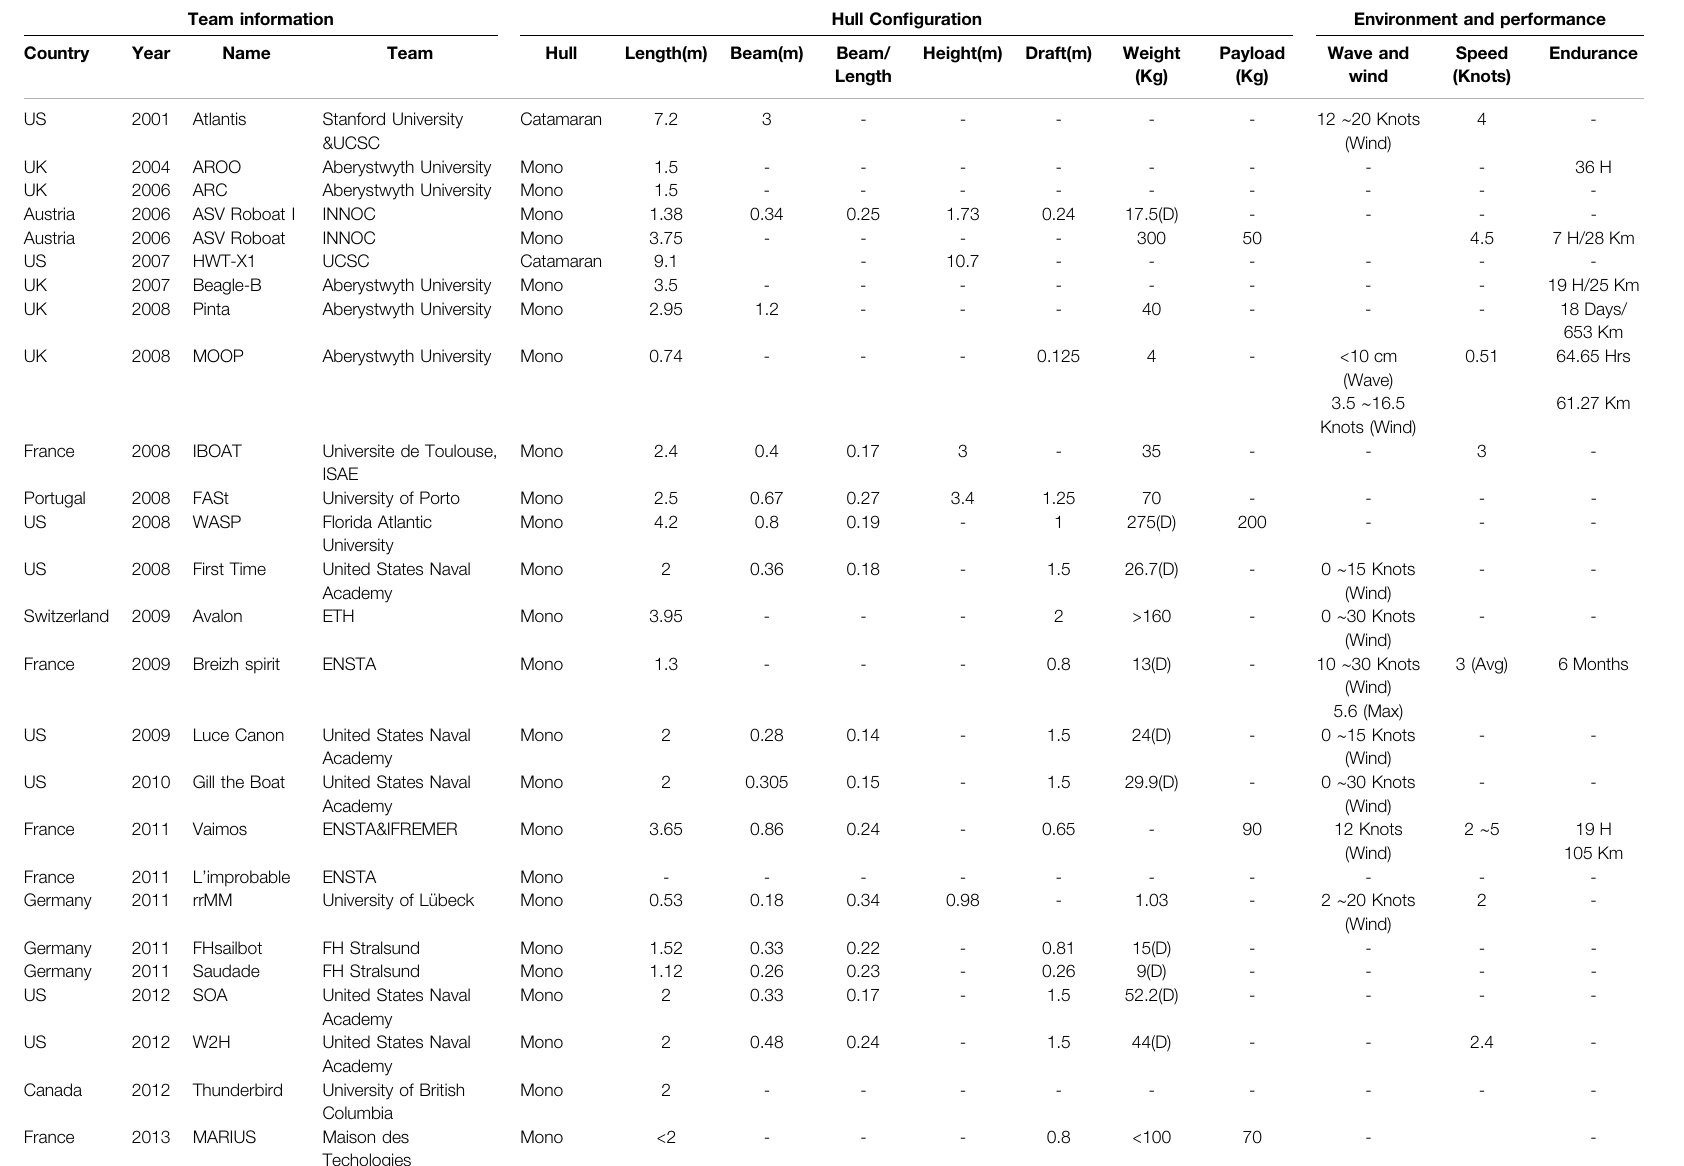
TABLE 1 | The sailboats con fi guration about team information, hull con fi guration and environment in different research groups. Noted: The column of “ Beam/Length ” represents the ratio between beam and length; In “ Weight (Kg) ” column, If the data ended with “ (D) ” , which is described the data is displacement. Otherwise, the data is the weight of sailing